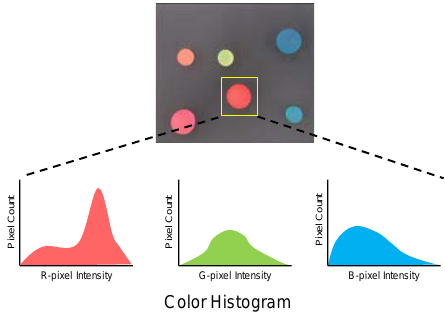
Figure 10. RGB histogram calculation.